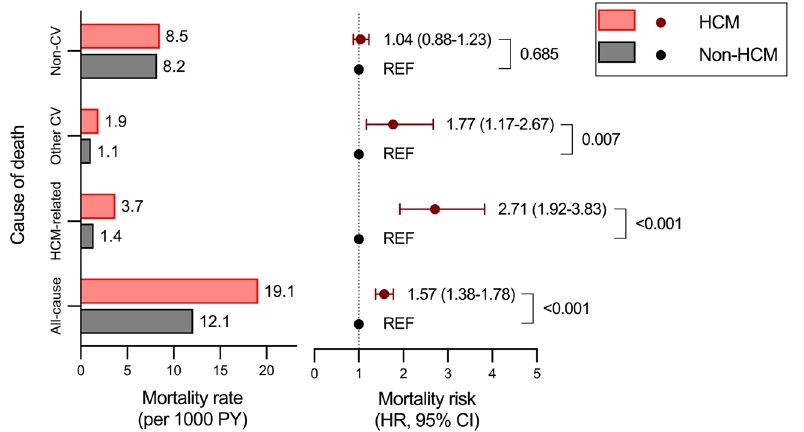
Figure 3. Mortality rates and risks according to the cause of death. Mortality rates, mortality risks with 95% CIs, and p-values are presented. Mortality rates were higher in the HCM group than in the non-HCM group, irrespective of the cause of death. Compared to the non-HCM group, the HCM group was associated with significantly higher risks for all-cause, HCM-related, and other cardiovascular mortality. Non-cardiovascular mortality was comparable in the HCM group versus the non-HCM group. HCM hypertrophic cardiomyopathy, CV cardiovascular, REF reference, PY person-year, HR hazard ratio, CI confidence